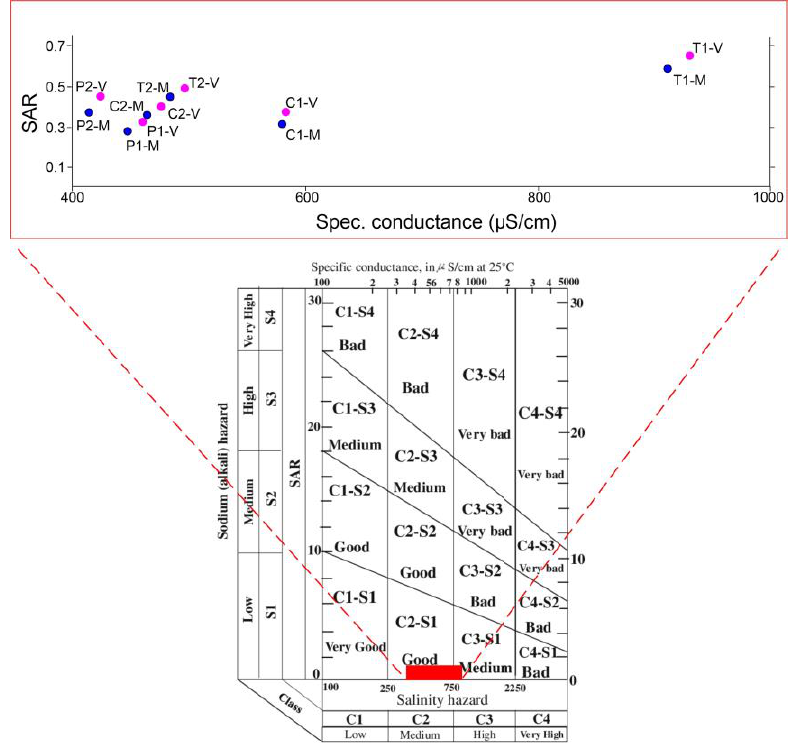
Figure 6. Relationship between S.A.R. index and Electrical conductivity for the 12 samples analyzed and positioning of the graph within the more general Wilcox diagram (on the right).